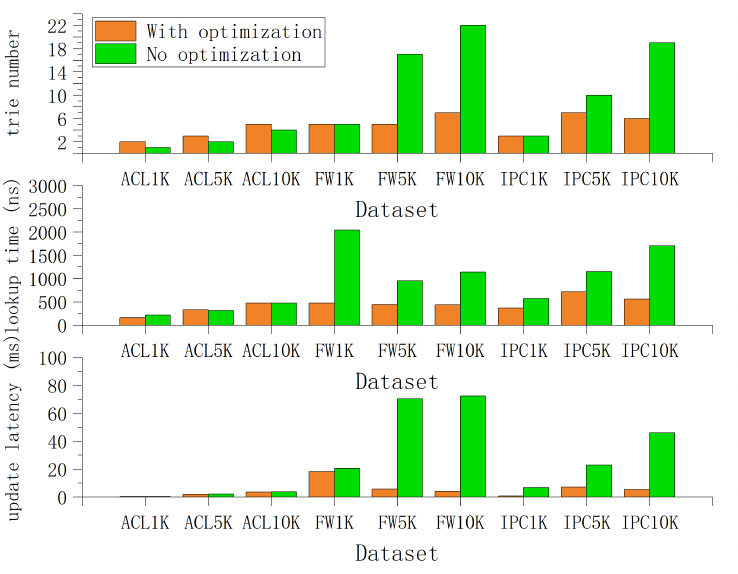
Figure 5. Performance of online trie-based method with and without